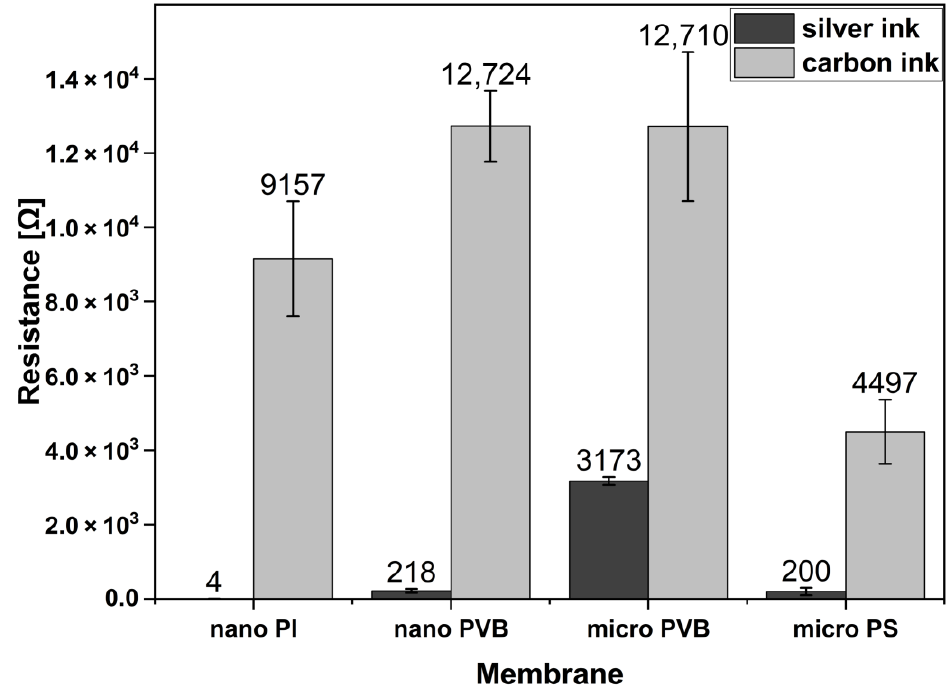
Figure 7. Resistance of silver and carbon conductive path printed on nano PI and nano PVB, micro PVB and micro PS electrospun membranes. On top of the columns, the exact values of the resistance are provided.